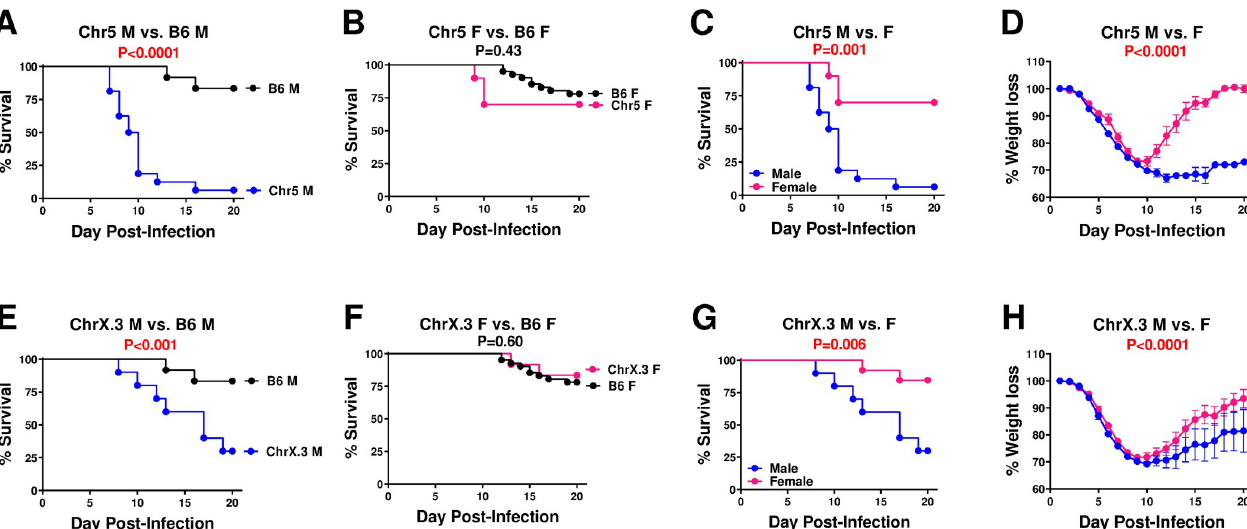
Fig 4. Genotype-dependent sex differences in IAV susceptibility of B6.Chr PWD consomic mice. Male (M) and female (F) B6 control and B6.Chr5 PWD ( A-D ) and B6.ChrX.3 PWD ( E-H ) mice were infected with sex-adjusted doses of PR8 as in Fig 2B . The following comparisons were made: ( A and E ) male consomic vs. male B6 control, ( B and F ) female consomic vs. female B6 control, and ( C, D, G and H ) male vs. female of each consomic. Significance of difference in survival for each comparison assessed by Mantel-Cox test, while significance of difference in weight loss was assessed by two-way ANOVA (overall effect of sex). The P value for each comparison is indicated in each corresponding graph, in red font if below P < 0.05. Complete data on survival analysis for all consomic strains are presented in Tables 1 and 2.